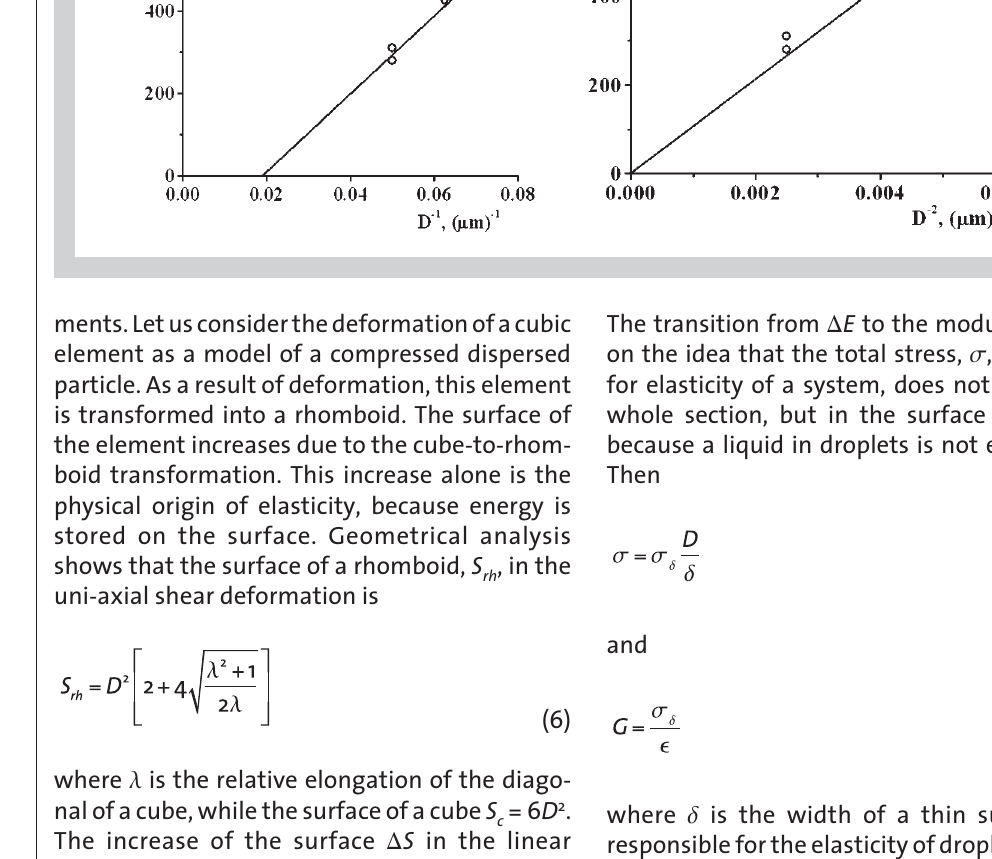
Figure 6: Dependencies of elastic modules on the reciprocal droplet size in reciprocal lin- ear (left) and squared (right)